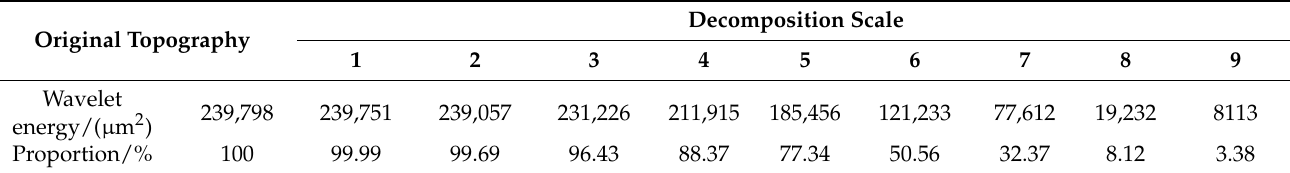
Table 1. Wavelet energy and its proportions of low-frequency reconstructed topography under different decomposition scales. Original